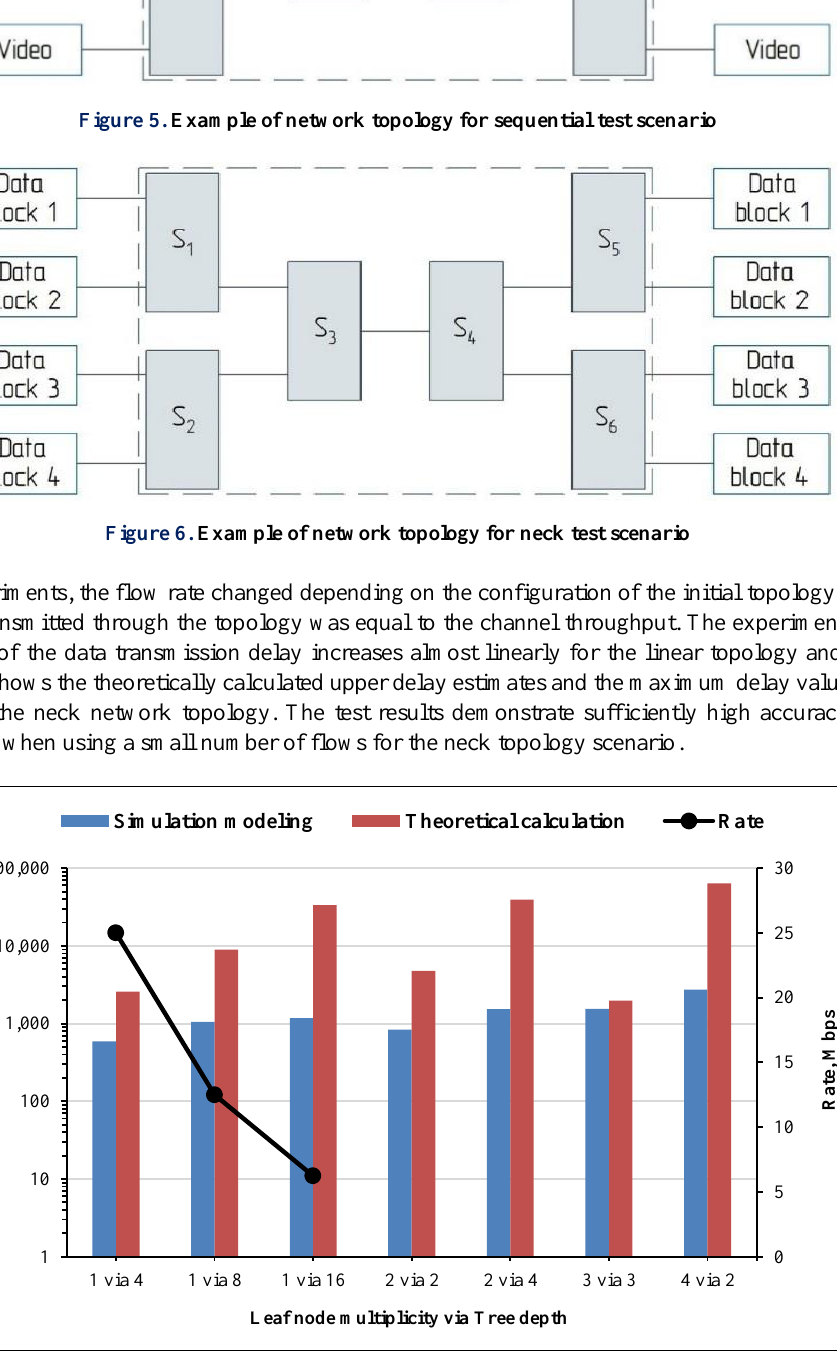
Figure 7. Dependence of upper theoretical estimates and maximum simulated data transmission delays for different combinations of topology and number of